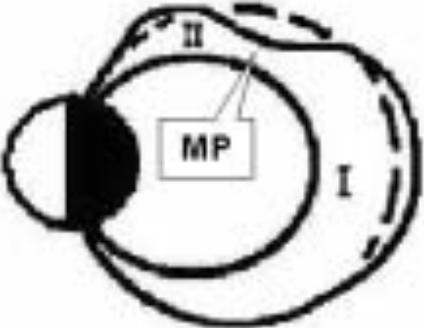
Fig. 11. Schematic illustrating nested magnetic bottles, where the new mirror point (MP) in the magnetic field produced due to the propagation earthward of a magnetic pulse, separates the dipole magnetic field into two regions (labelled I and